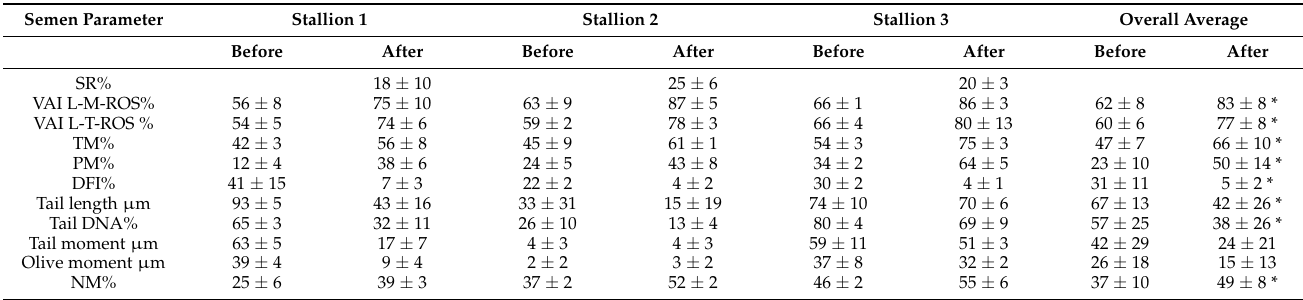
Table 4. Effect of a modified flotation density gradient centrifugation (DGC) protocol on the sperm recovery (SR), viable acrosome-intact spermatozoa with low mitochondrial reactive oxygen species (VAI L-M-ROS), viable acrosome-intact spermatozoa with low total cellular reactive oxygen species (VAI L-T-ROS), total motility (TM), progressive motility (PM), DNA fragmentation index (DFI), comet assay tail length, tail DNA, tail moment, olive moment and normal morphology (NM) for 3 Friesian stallions (3 ejaculates per stallion, n = 9) with a high initial DFI. Within a row, an asterisk indicates values that differ before and after the modified flotation DGC ( p ≤